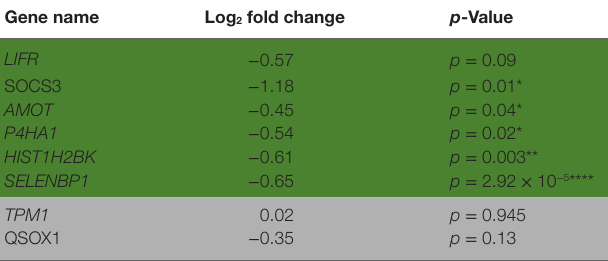
TaBle 2 | Dormancy genes are downregulated by parathyroid hormone-related protein (PTHrP) in MCF7 cells. gene name